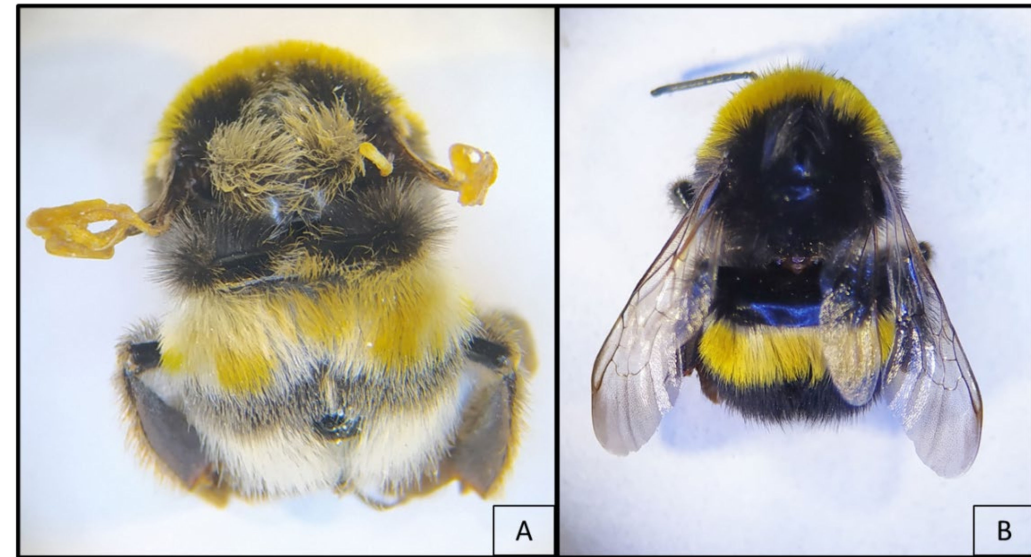
Figure 1. Bombus terrestris workers with crippled ( A ) and normal ( B ) wings. Individual A shows yellow and white patches of anomalous